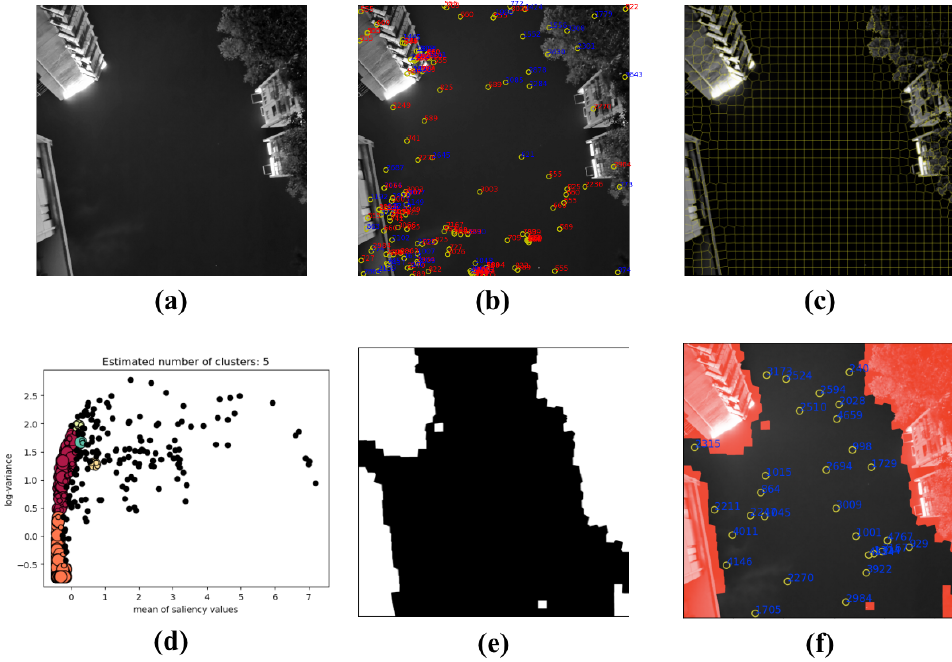
Figure 17. ( a ) The star image; ( b ) extraction results with the Wavelet-LOF algorithm (there are many false star spots); ( c ) result of SLIC segmentation; ( d ) result of DBSCAN clustering; ( e ) binary mask generated by proposed method; and ( f ) result of star spots extraction with the mask. The red points indicate incorrect recognition, and the blue points indicate correct recognition.